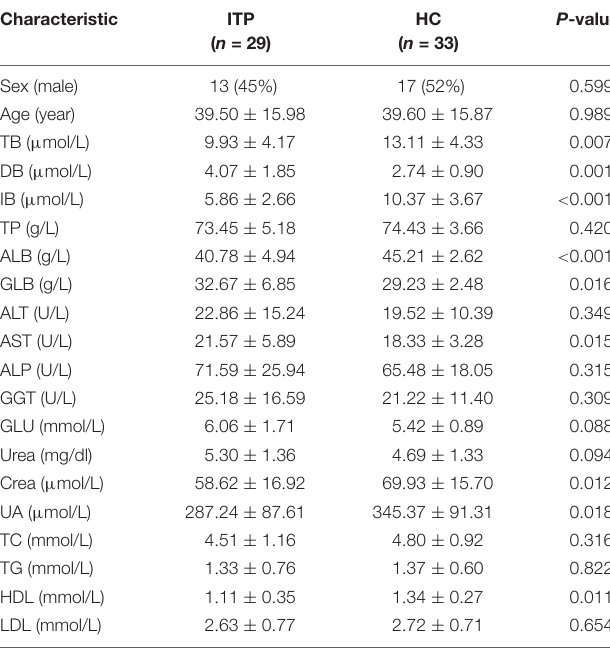
TABLE 1 | Demographic, clinical and metabolite characteristics of the study